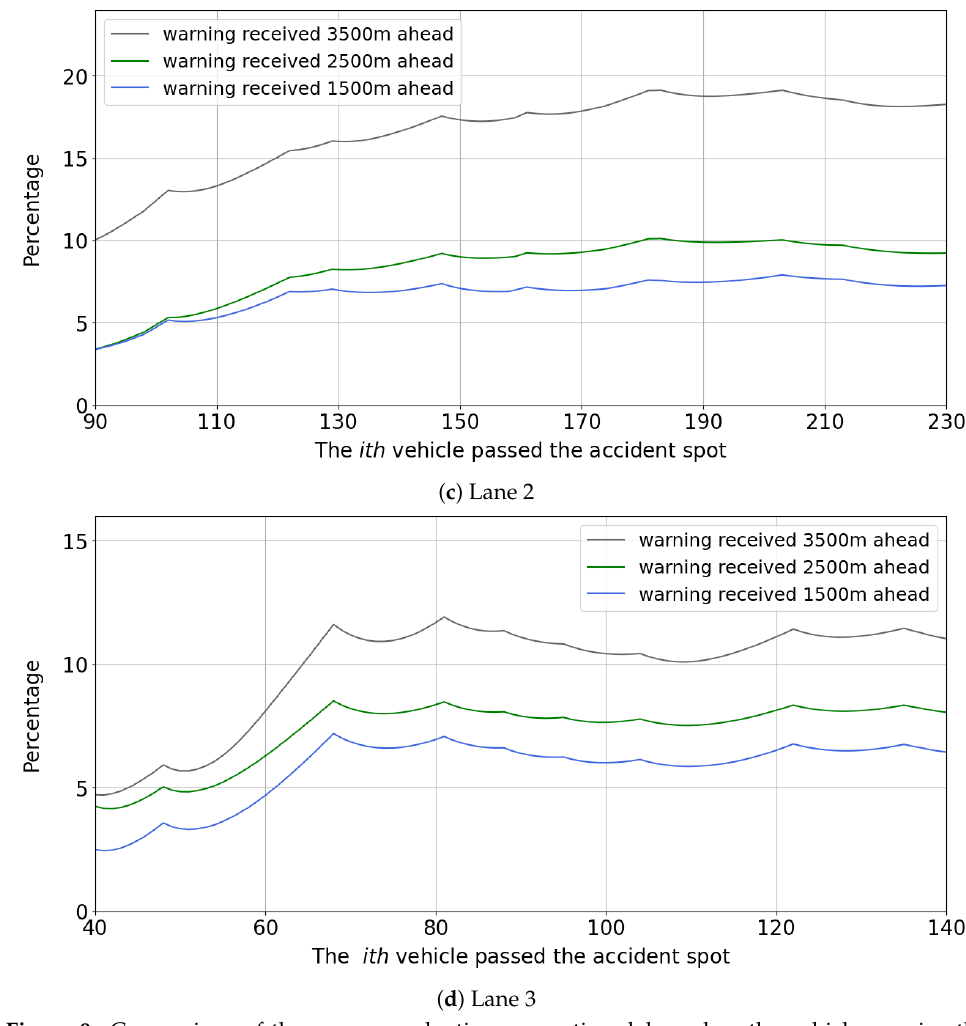
Figure 9. Comparison of the average reduction congestion delay when the vehicles receive the warning message at 3500 m, 2500 m, and 1500 m